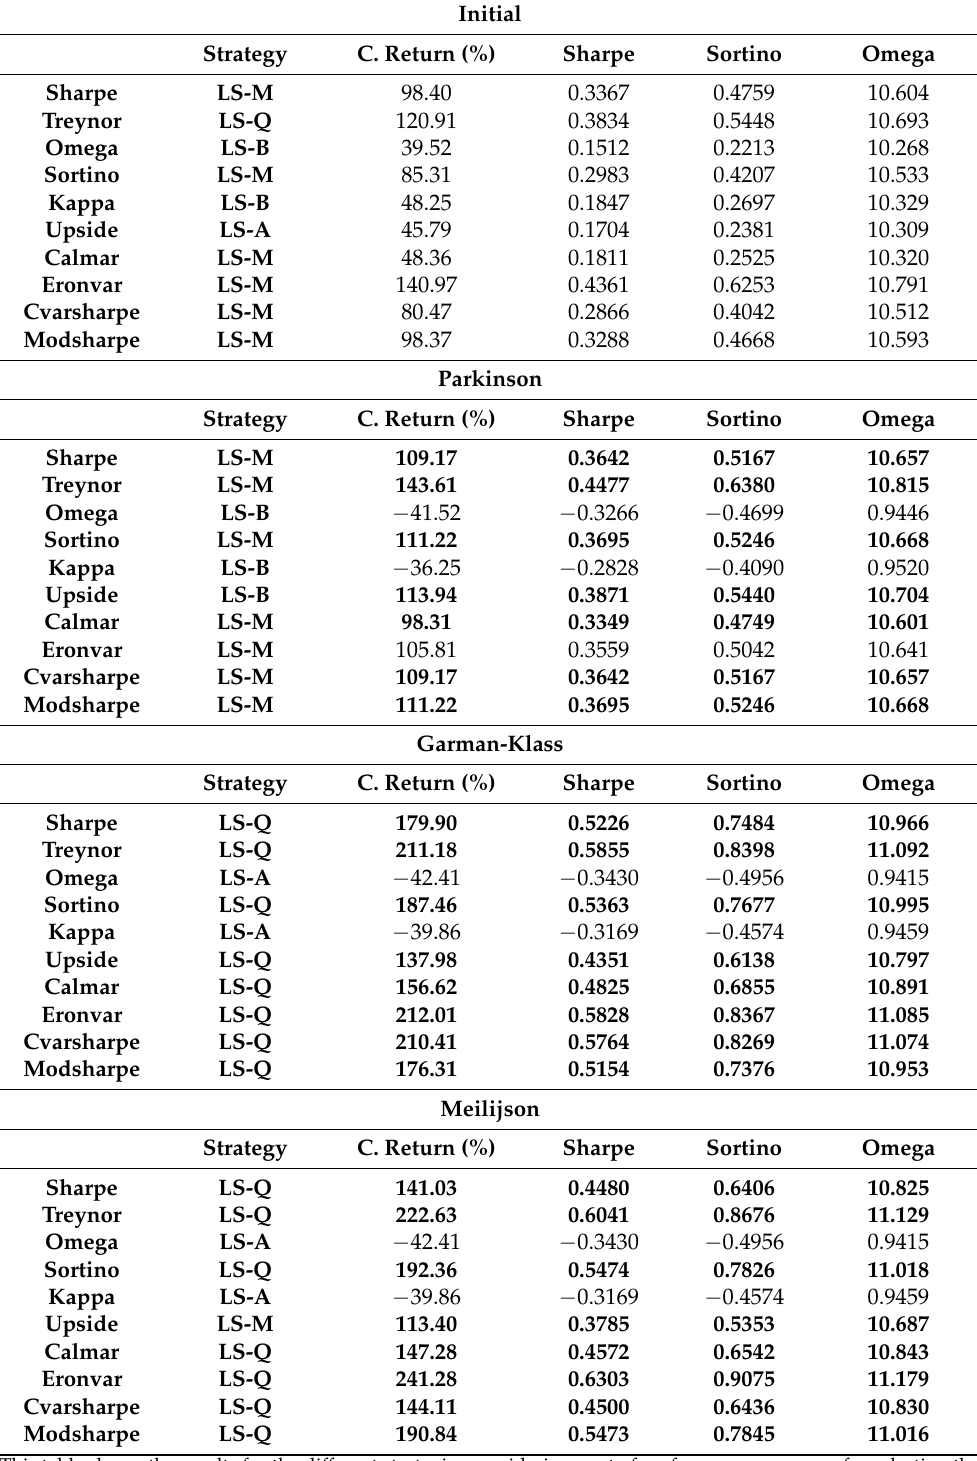
Table 8. Performance evaluation (including transaction